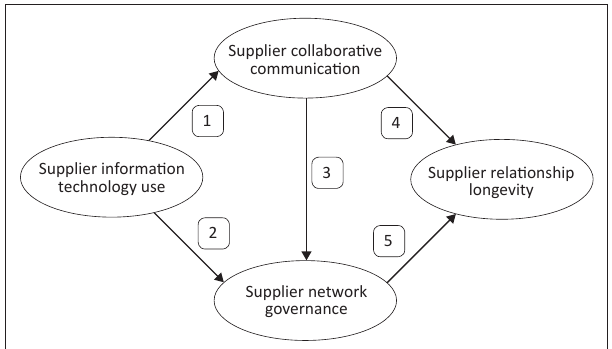
FIGURE 1: Conceptual